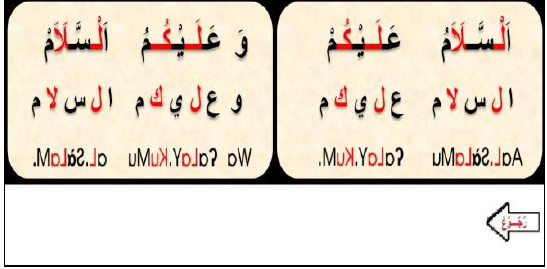
Figure 18. Phonetics transcription support and independent Arabic letters in the e-Learning